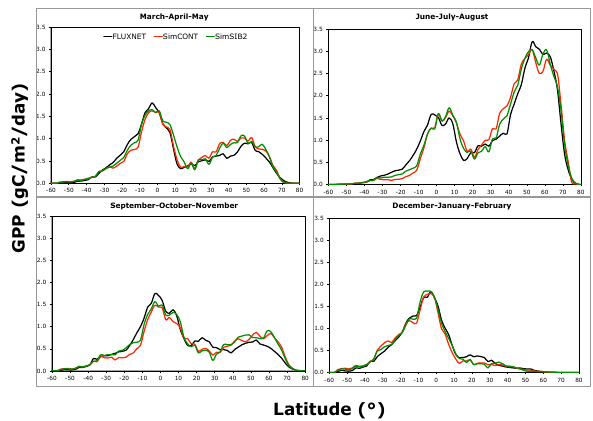
Fig. 4. Seasonal zonal average GPP simulated in SimCONT Figure 4. Seasonal zonal average GPP simulated in SimCONT and SimSiB2 compared and SimSiB2 compared to the FLUXNET-derived data set to the FLUXNET-derived dataset (gC/m 2 /day). (gCm − 2 day − 1